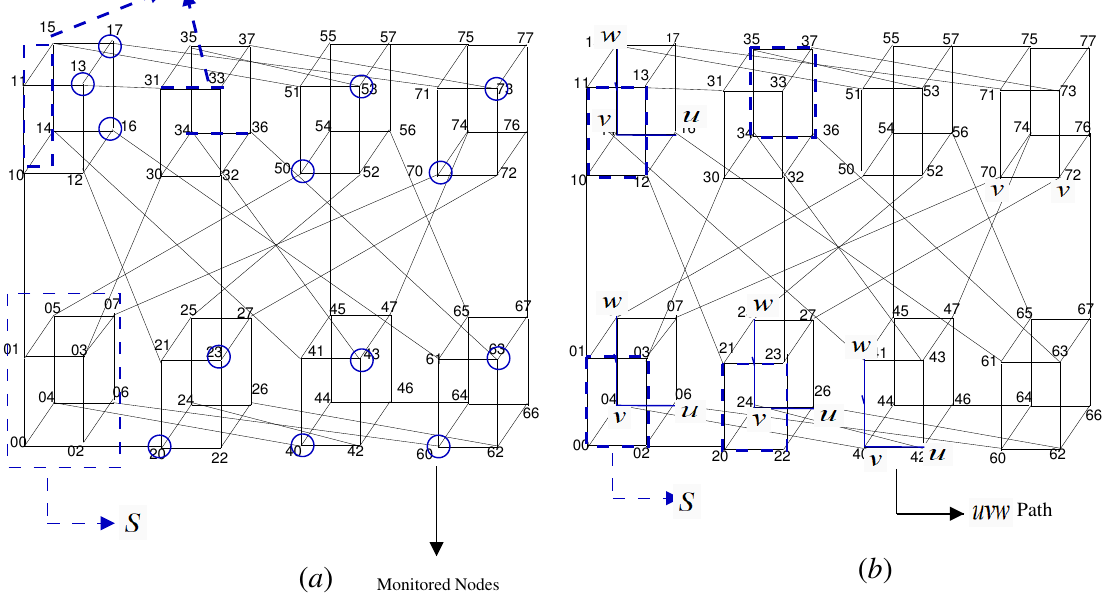
Figure 4. Circled vertices indicates in ( a , b ) be a zero forcing sets of H 2